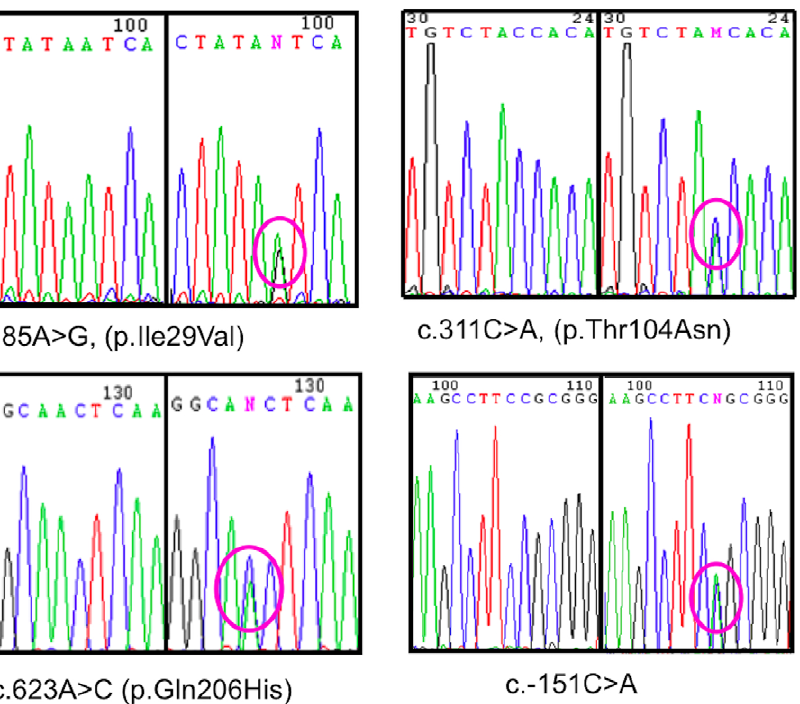
Figure 1. Chromatograms showing nucleotide changes in CHMP2B . On the left side of each image is the normal wild-type sequence, whilst the right side shows the nucleotide change for each of the changes identified in CHMP2B .